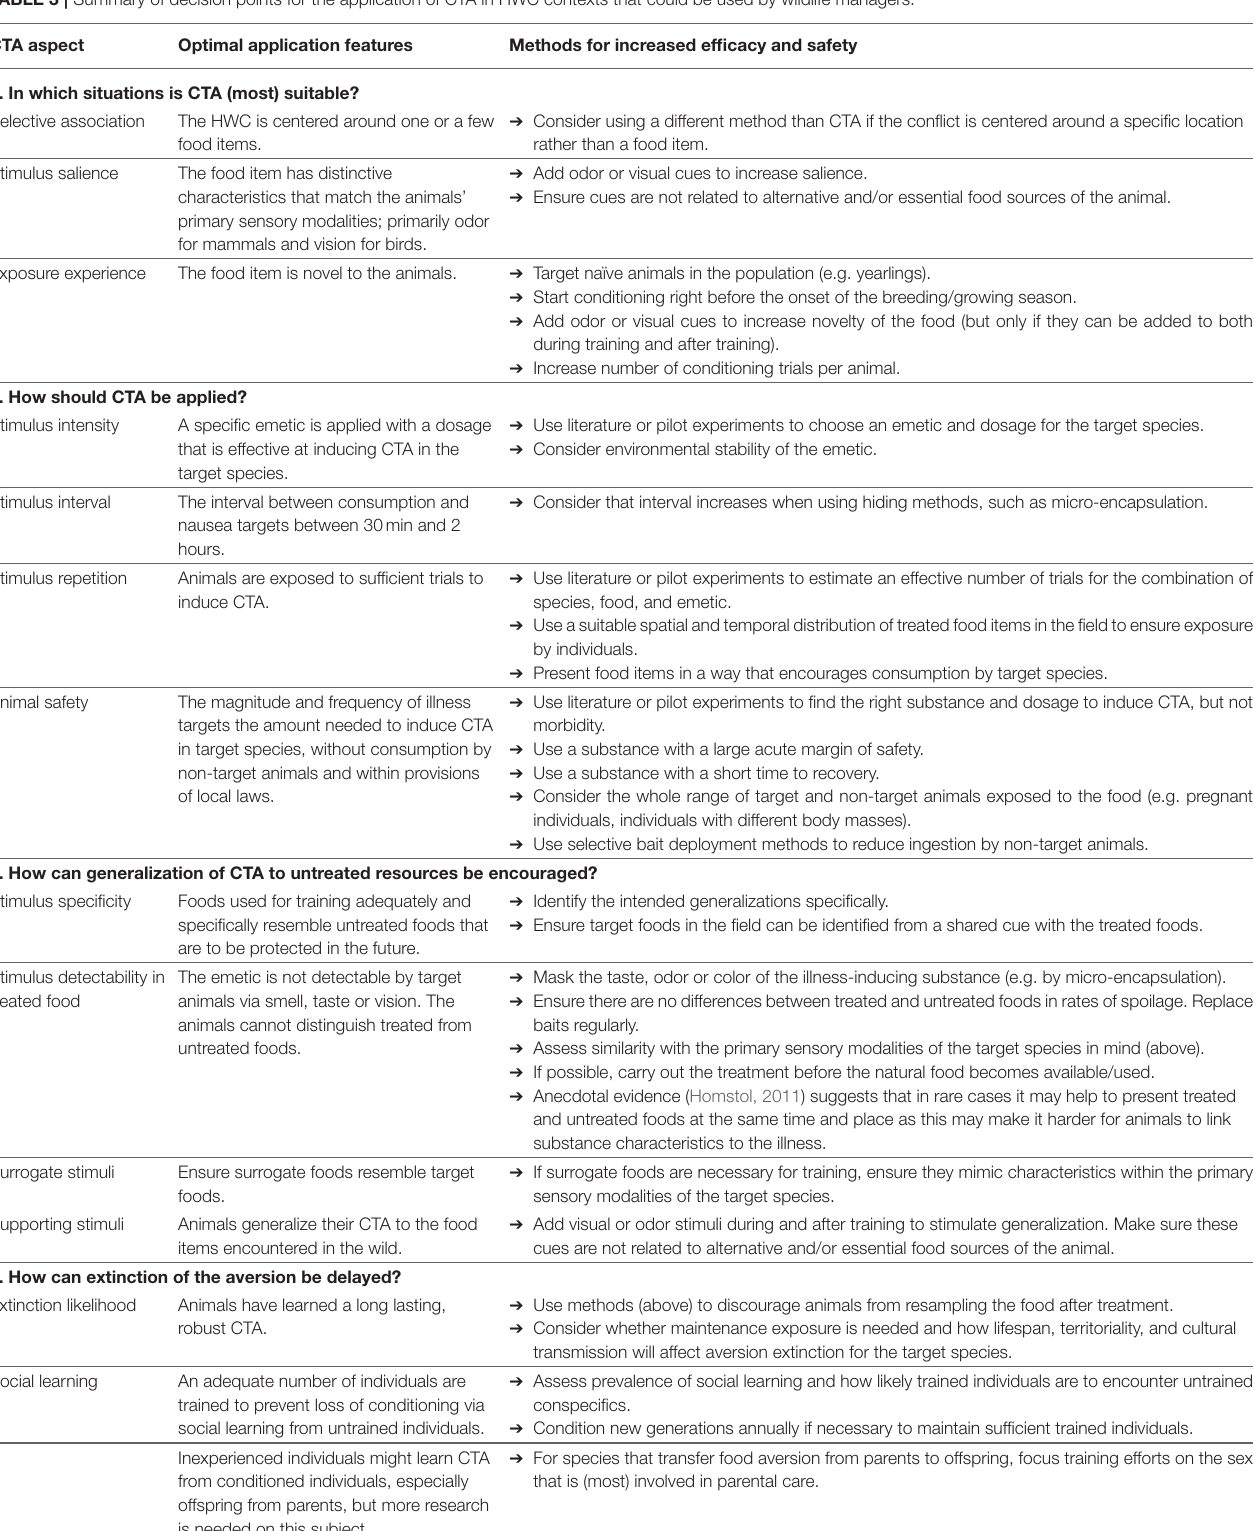
Table organization replicates the application sections of our review to identify four main questions concerning the application of CTA. These questions are then divided among aspects of its implementation with each followed by optimal application features and the methods we suggest for increasing efficacy and safety. These features are suggested by qualitative synthesis of the literature